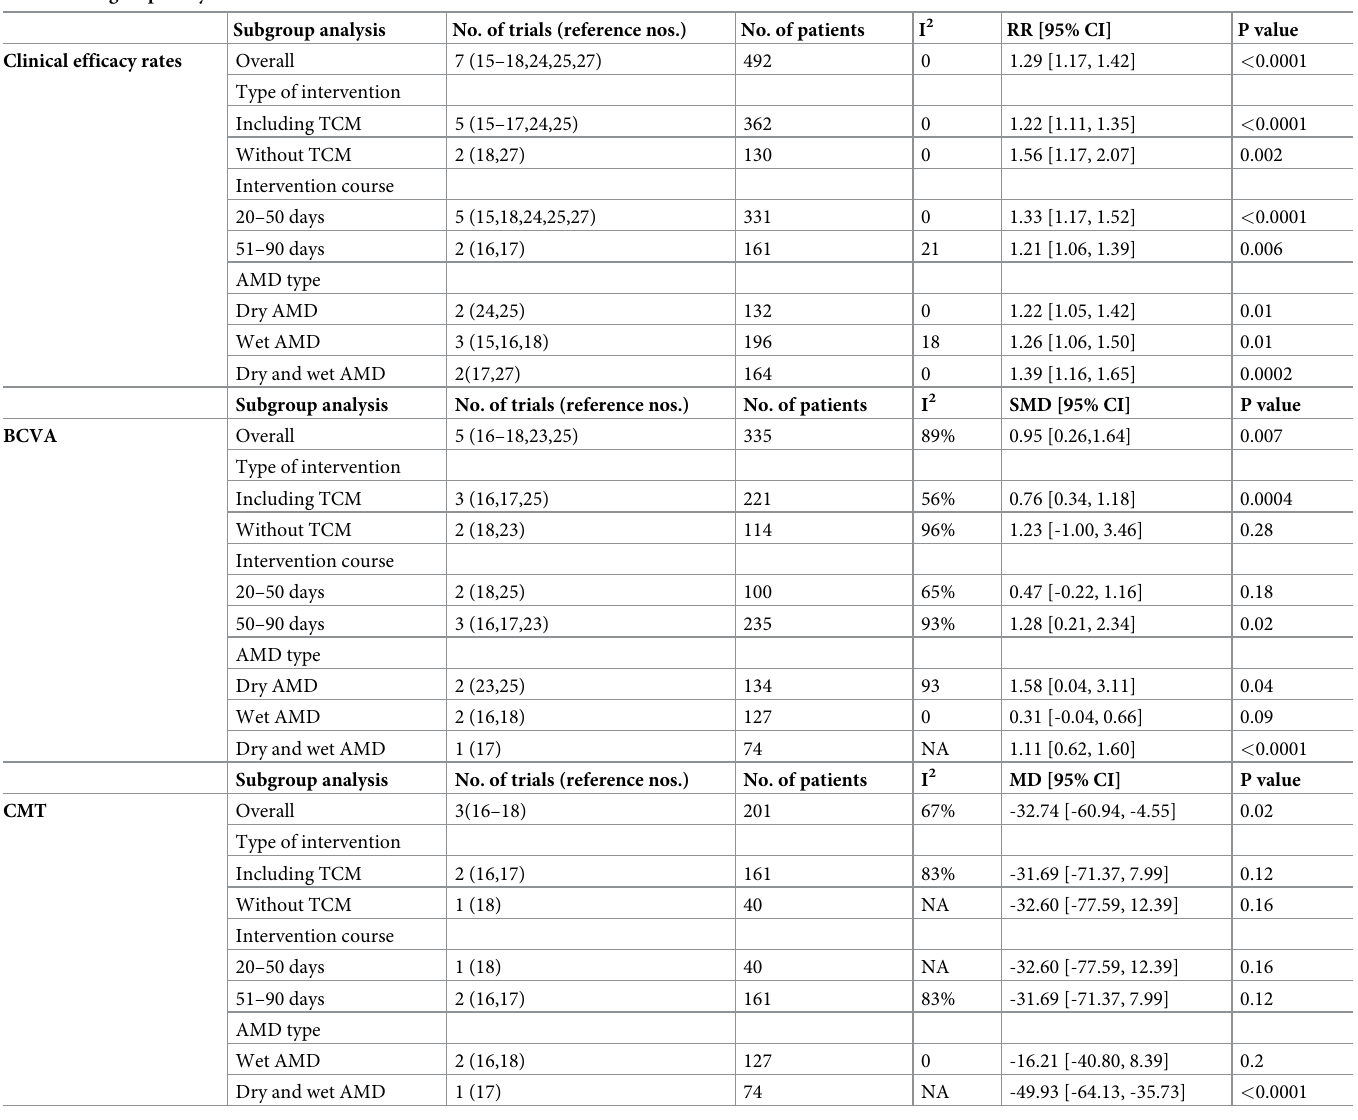
Table 3. Subgroup analysis.